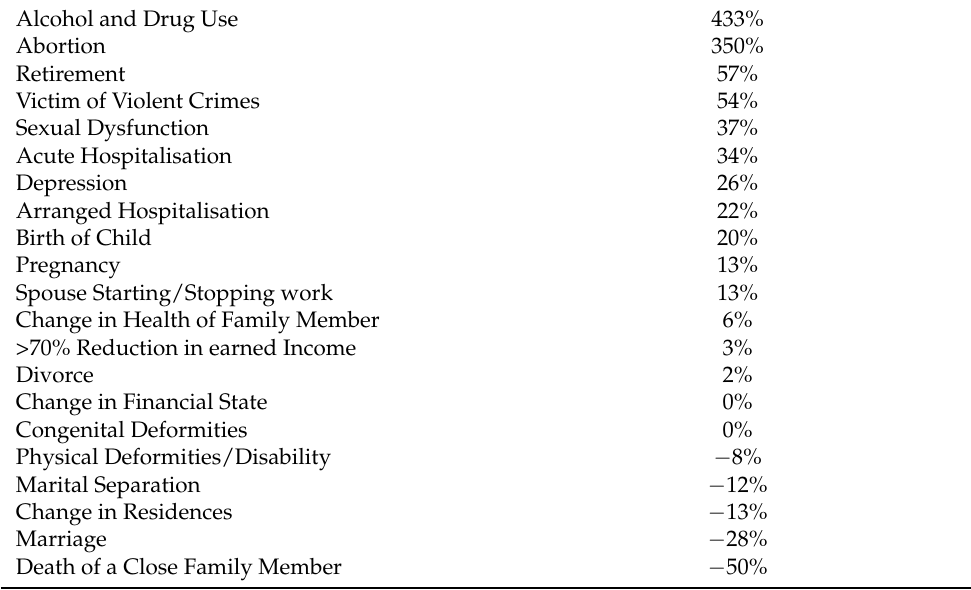
Table 1. For 1-move individuals, moving between their owned property to another owned property, the percentage changes in stress types, 7 quarters before to after the